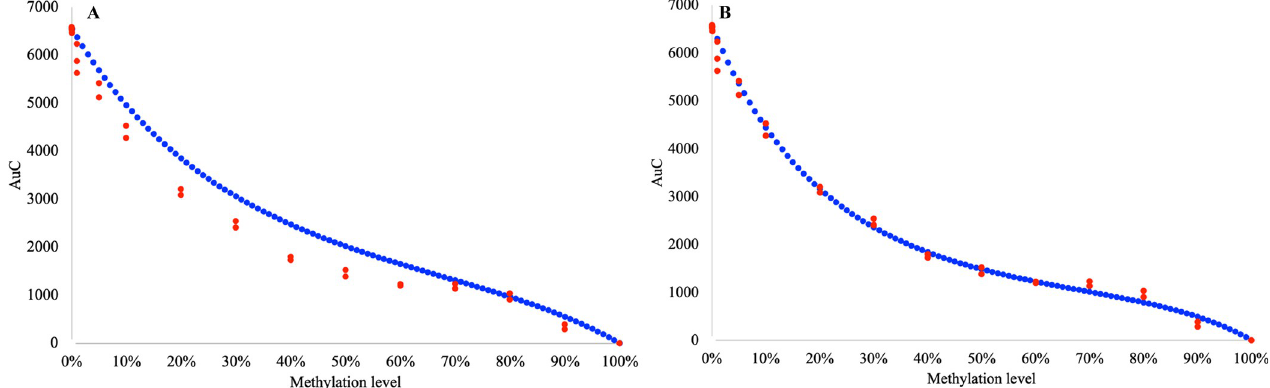
Fig 4. Comparison of the standard curve calculated using Eq 3 and observed AUC for each of the control mixes in the experiment for the EpiMelt MGMT assay. The standard curve (blue) describing the association relationship between AUC and methylation level calculated using Eq 3, and the observed values of AUC (red dots–triplicates for each of the control mixes) for the EpiMelt MGMT assay. (A) with M and N values set to 1 and (B) the standard curve with M-and N values calculated for this specific experiment with